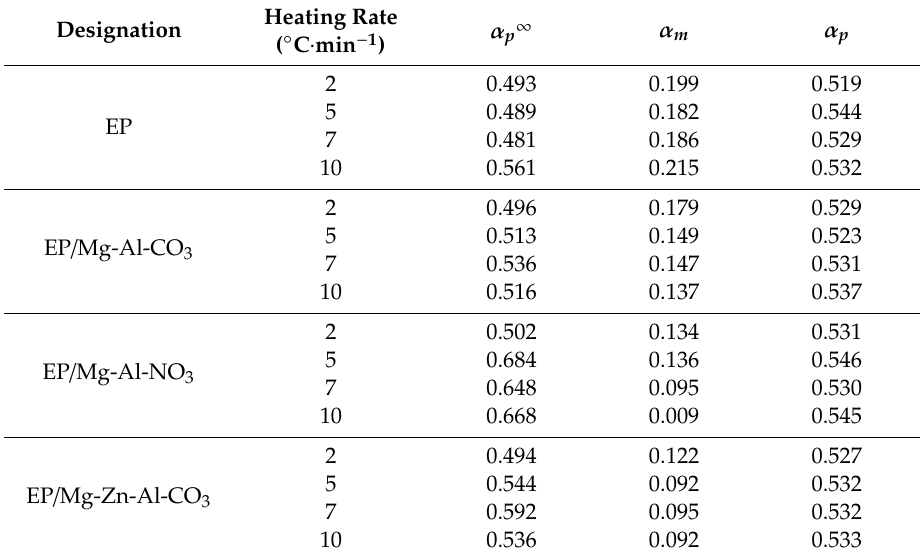
Table 1. The values of α p , α m and α p ∞ obtained from the M á lek model at various heating rates.